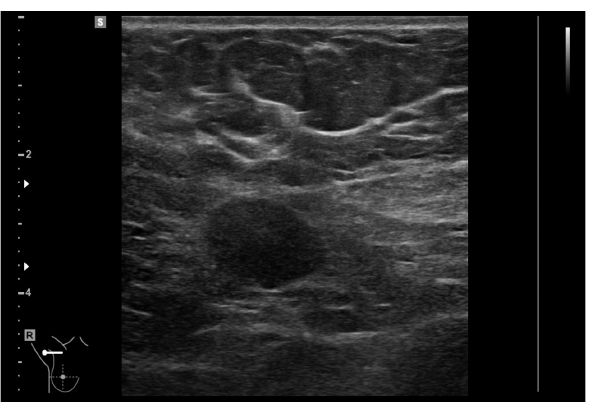
Fig. 5. Metastatic lymph node with focal cortical thickening (verified by core biopsy).